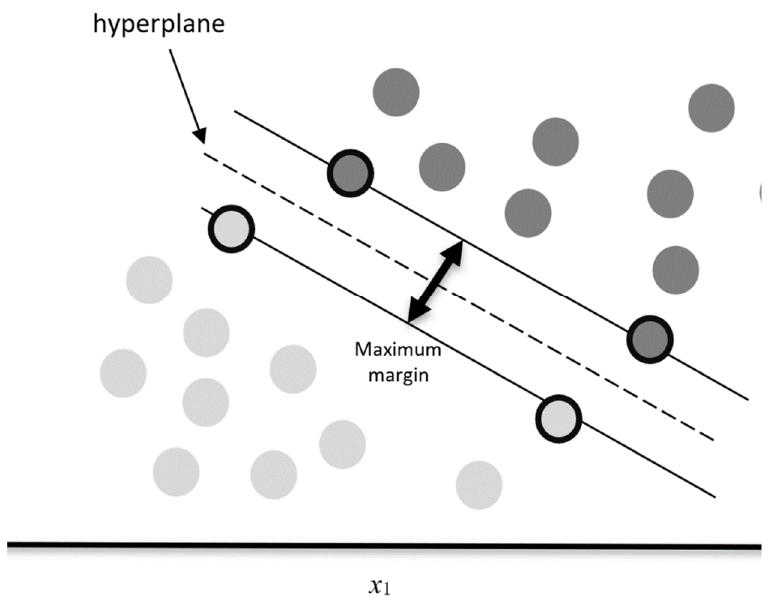
Figure 1. Hyperplane selection and support vectors. The pronounced black contour represents the SVs thus defining the margins with the dashed lines. The plain single line describes the separating hyperplane.